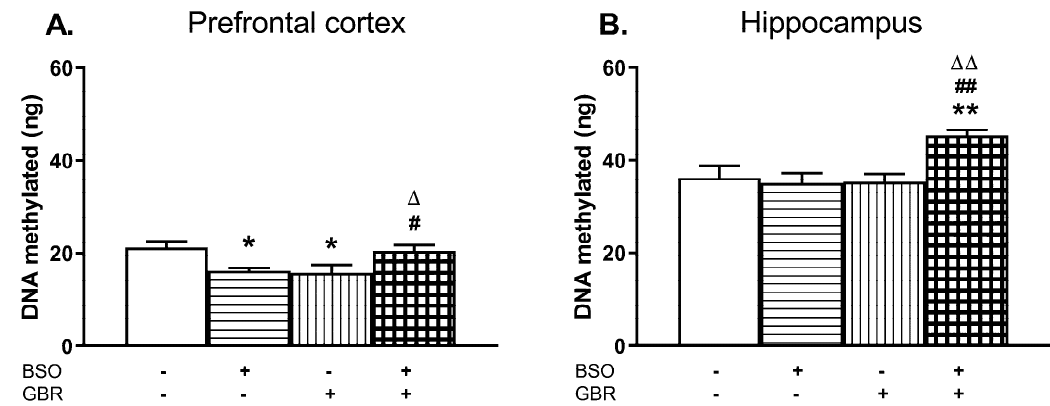
Figure 5. The effects of chronic administration of BSO and GBR 12909, alone or in combination, on the global DNA methylation in the PFC ( A ) and HIP ( B ) of 16-day-old rats. Statistical analysis was performed using a two-way ANOVA; symbols indicate significance of differences according to the Newman–Keuls post-hoc test, * p < 0.05, ** p < 0.01 vs. control; # p < 0.05, ## p < 0.01 vs. BSO-; and ∆ p < 0.05, ∆∆ p < 0.01 vs. GBR 12909-treated groups.